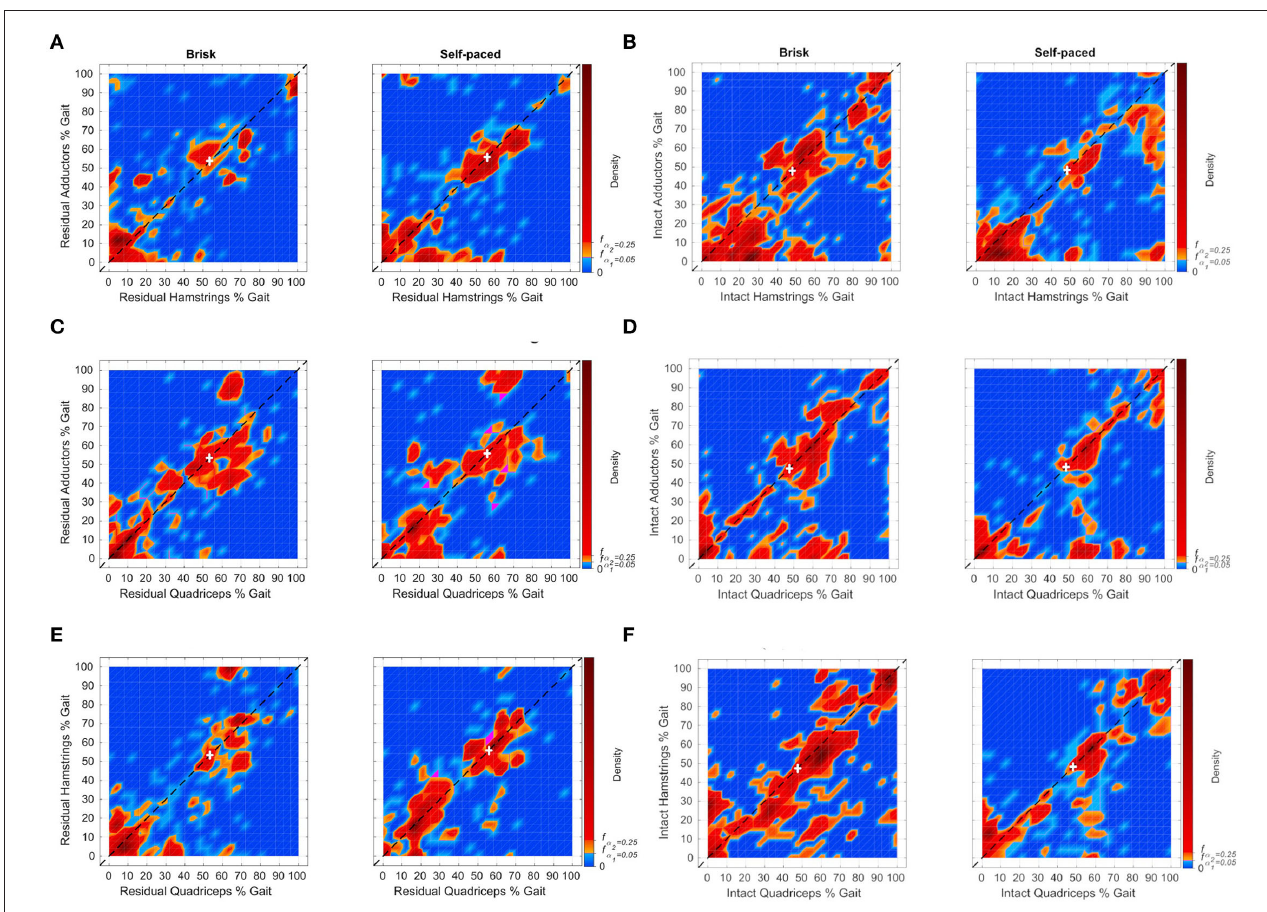
FIGURE 2 | Distributions of muscle peak pairing times between the adductors, hamstrings, and quadriceps muscle groups, from 6 individuals with OTFA for the residual (A,C,E) and intact (B,D,F) limbs. Individual points can be found in Supplementary Figure S6 . Time zero corresponds to the heel-strike of the corresponding limb. Pairings that occur near or along the diagonal indicate co-contraction between muscle groups. The white cross indicates the mode of the distribution of the stance duration. Distributions of the stance duration are in shown Supplementary Figure S3 . The subfigures depict the relative frequency of peak pairing times that occur during the gait cycle. Orange and red are within the 95% high density region (HDR). Red indicates points within the 75% HDR. Magenta refers to points with density equal to the 95% HDR threshold f α 1 . For the residual limb, HDRs along the diagonal are prior to 80%, with the exception of residual adductorshamstrings for both tasks and adductorsquadriceps for selfpaced. The HDR after 90% for residual adductors-hamstrings for brisk is composed of muscle peak pairings largely from one participant. The HDR after 90% for residual adductors-hamstrings for self-paced is composed of peak pairings from two subjects. The HDR after 90% for residual adductorsquadriceps for self-paced is composed of peak pairings from three subjects. For the intact limb, HDRs along the diagonal occur throughout the gait cycle.